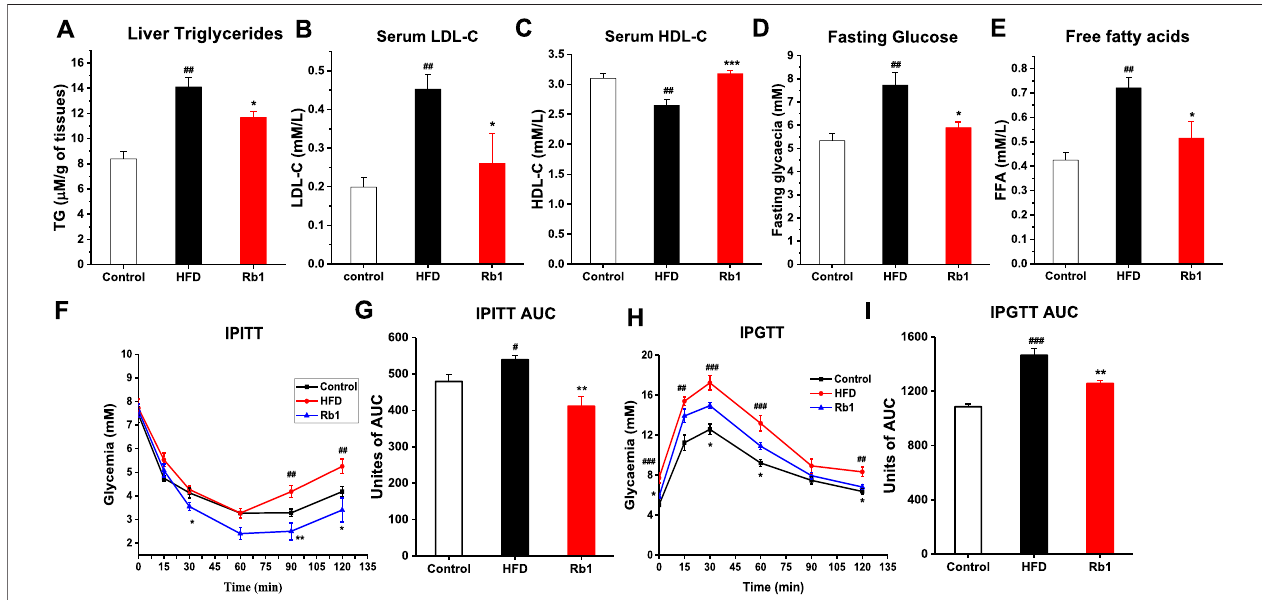
FIGURE2| TheeffectsofRb1supplementation onlipidpro fi lesandglucosehomeostasis. (A) Livertriglycerides; (B) Low-densitylipoproteincholesterol; (C) High- density lipoprotein cholesterolin serum. (D) Fastingglucose; (E) Free fatty acids in serum. (F) Mice foran insulin tolerance test were 6 h fasted and IPITT wasperformed after anintraperitoneal injection of insulin (0.7 UI/kg body weight). (G) Areaunderthe curve for insulin tolerance test. (H) Animalswere fasted overnight(12 h)and an oral glucose tolerance test IPGTT was performed after gavage with glucose (1 g/kg body weight). (I) Area under the curve for IPGTTs. The data are expressed as the mean ± SEM; n (cid:1) 6; one-way analysis of variance with Tukey ’ s post-hoc test. # p < 0.05, ## p < 0.01, and ### p < 0.001 for NC vs HFD; * p < 0.05, ** p < 0.01, and *** p < 0.001 for Rb1 vs HFD.